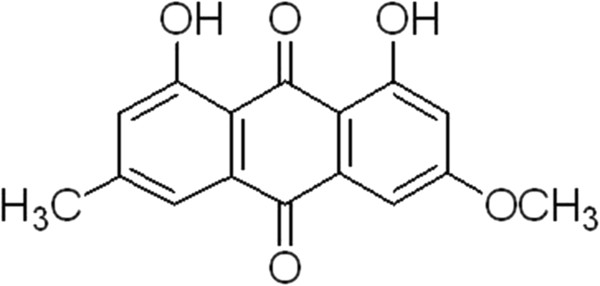
The molecular formula picture of emodin.